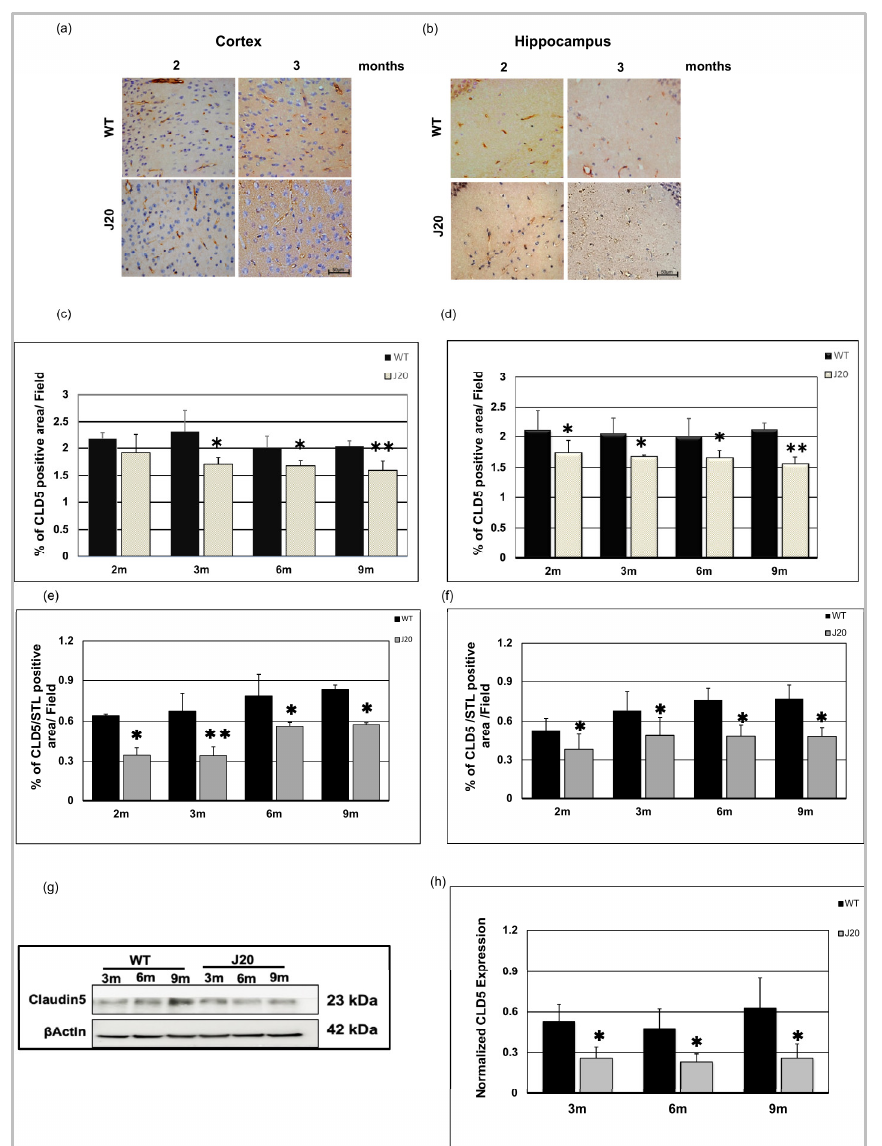
Figure 4. Decreased expression of claudin-5 level in J20 mice. Claudin-5 immunoreactivity in the cortex ( a ) and hippocampus ( b ) of both WT and J20 mice at 2 and 3 months. Endothelial cells of the vasculature exhibit immunoreactivity for the claudin-5 protein (brown). Decreased claudin-5 expression was found for endothelial cells in the J20 mice brain. Densitometric analysis by ImageJ as a percentage of claudin-5 positive areas per field (×40) in the cortex ( c ) and hippocampus ( d ) was shown in the graph (Figure S1). Percentage of claudin-5/STL positive areas per field (×40) in the cortex ( e ) and hippocampus ( f ) was shown in the graph. ( g ) Representative immunoblot of claudin- 5 protein expression in the hippocampus of WT and J20 mice brains at 3, 6, and 9 months of age. ( h ) Normalized hippocampal claudin-5 expression of different group at 3, 6, and 9 months. Numerical data are presented here as average ± SD, and statistical significance is denoted as * p < 0.05, ** p < 0.01 vs. age-matched WT. CLD5 = claudin-5. M indicates month. Scale bar = 50 µm.